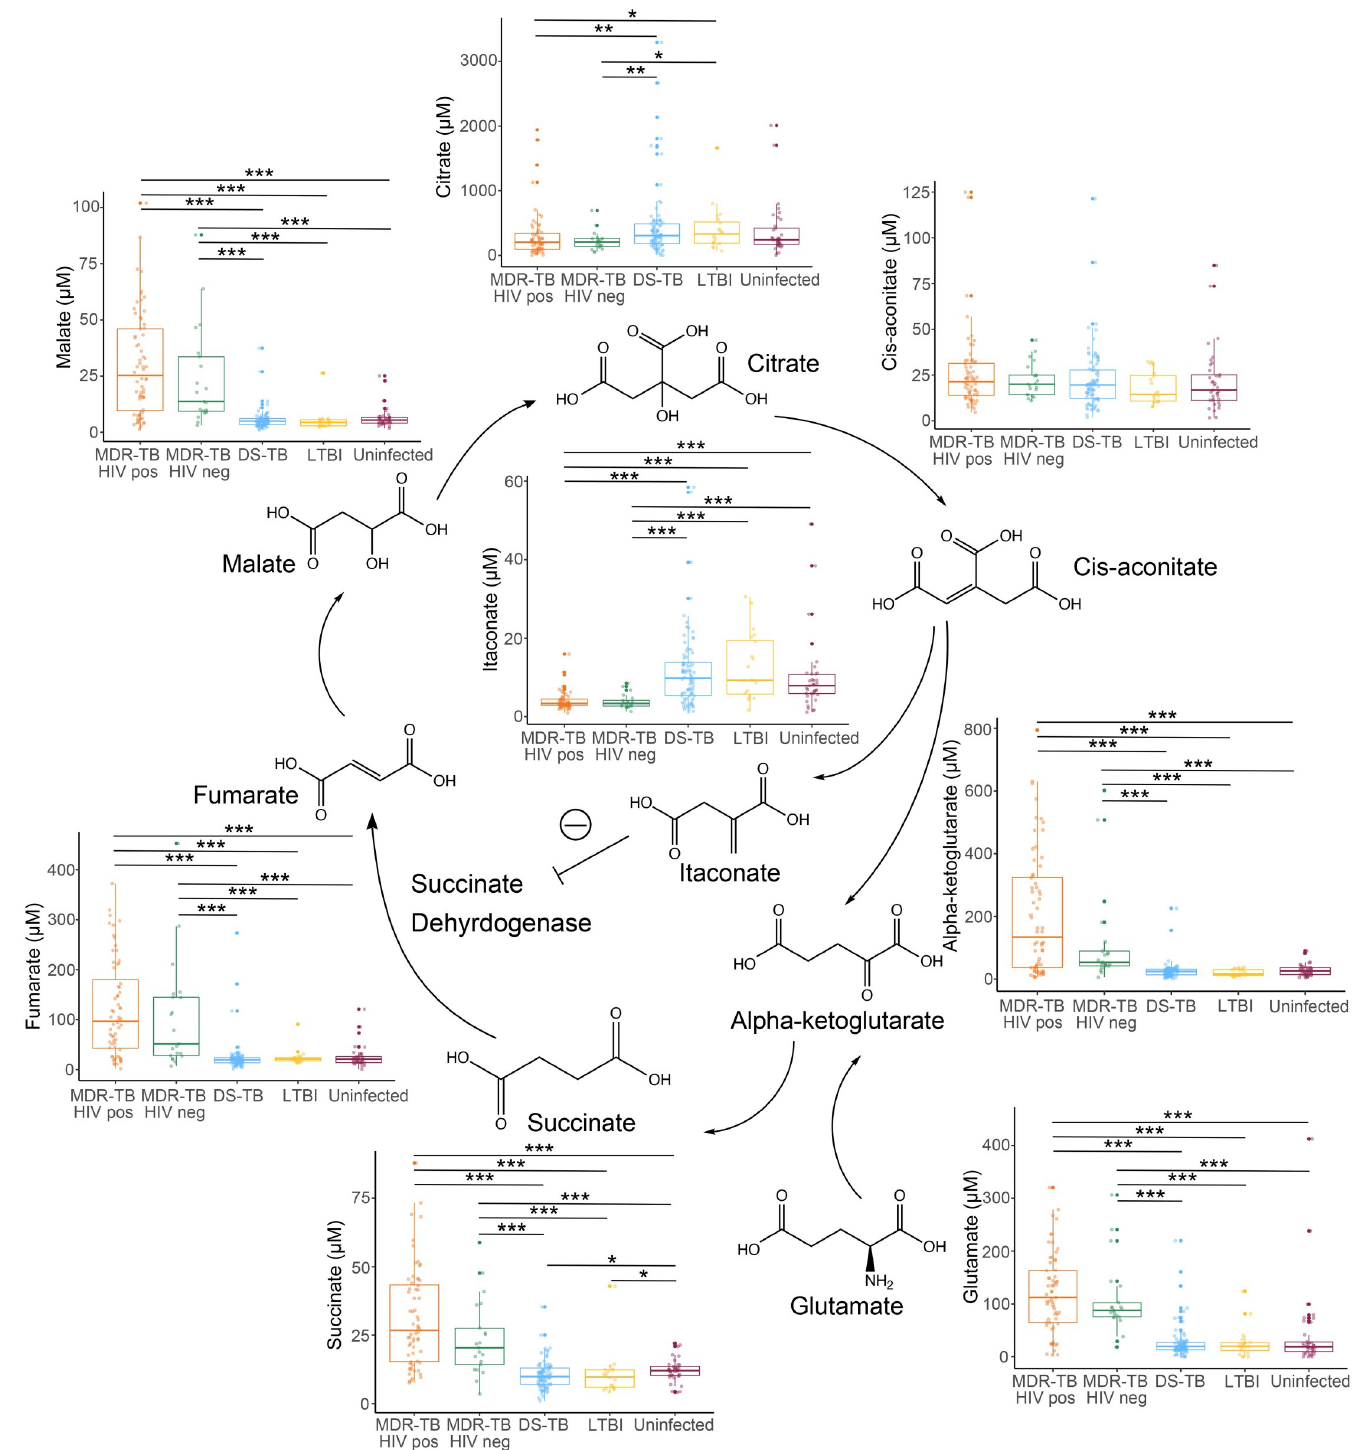
Fig 2. Characterization of TCA cycle remodeling in MDR-TB. Plasma quantification of TCA cycle metabolites in persons with multidrug resistant (MDR)-TB with (orange; n = 64) and without (green; n = 21) HIV co-infection shows significant increases in the metabolites alpha-ketoglutarate, succinate, fumarate, and malate versus persons with drug susceptible (DS)-TB (blue; n = 89), LTBI (yellow; n = 20), and controls without LTBI or TB disease (purple; n = 37). Plasma concentrations of glutamate were also significantly increased in MDR-TB while citrate was significantly decreased and concentrations of cis-aconitate were similar between groups. Plasma concentrations of the anti-inflammatory metabolite itaconate were significantly decreased in persons with MDR-TB. Groups were compared using the Wilcox rank sum test: � p < 0.05, �� p < 0.01, ��� p < 0.001. https://doi.org/10.1371/journal.ppat.1009941.g002 PLOS Pathogens| https://doi.org/10.1371/journal.ppat.1009941 September 24,